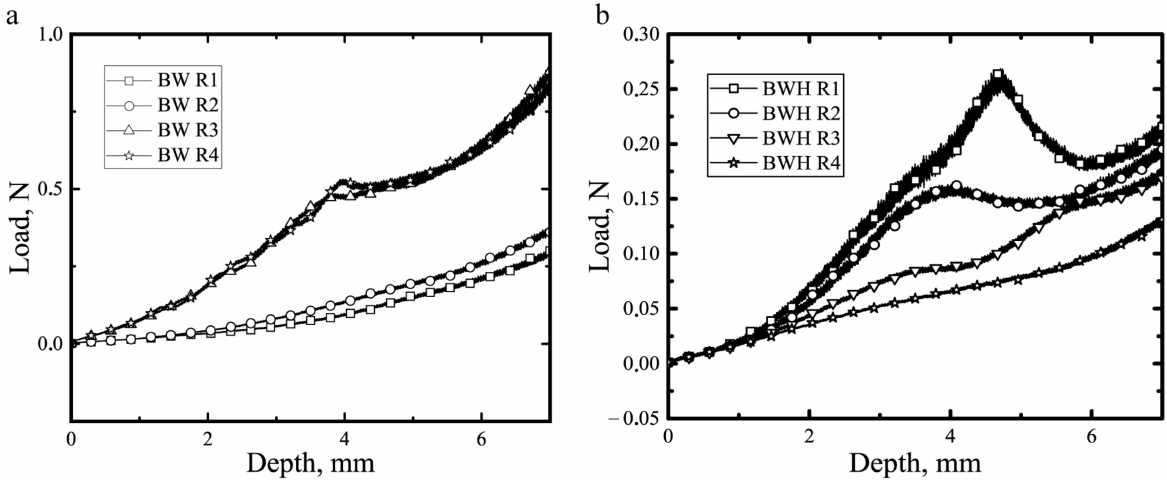
Figure 4. Characteristic load-displacement curves of beeswax ( a ) and beeswax hydrocarbons ( b ) based oleogels prepared with different cooling